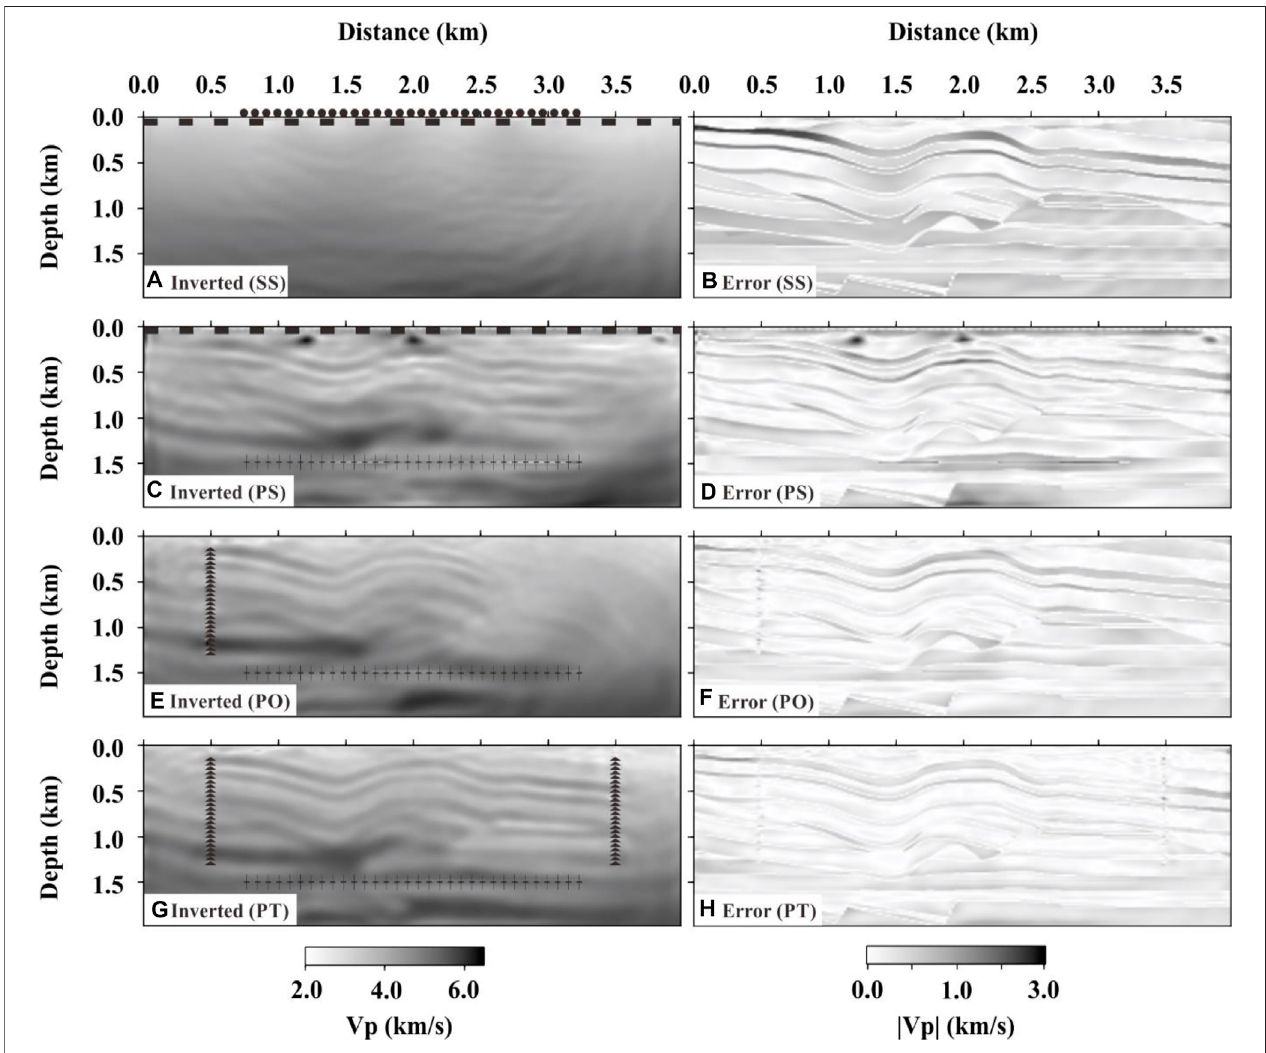
FIGURE 11 | Inversion results (Blocks A , C , E and G in the column on the left-hand side) of data contaminated with Gaussian noise (S/N = 2.0) and the absolute velocity error (Blocks B , D , F and H in the column on the right-hand side) relative to the actual velocity model. The results of SS, PS, PO, and PT data are marked in the bottom left corner of each